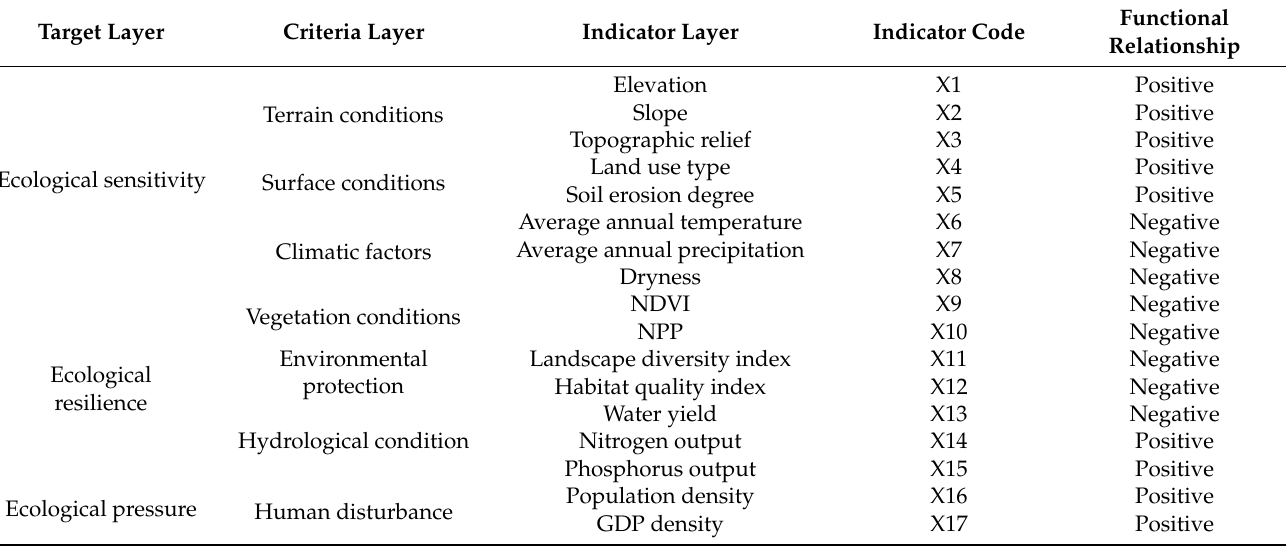
Table 2. The index system of ecological vulnerability assessment in the Nansi Lake Basin.